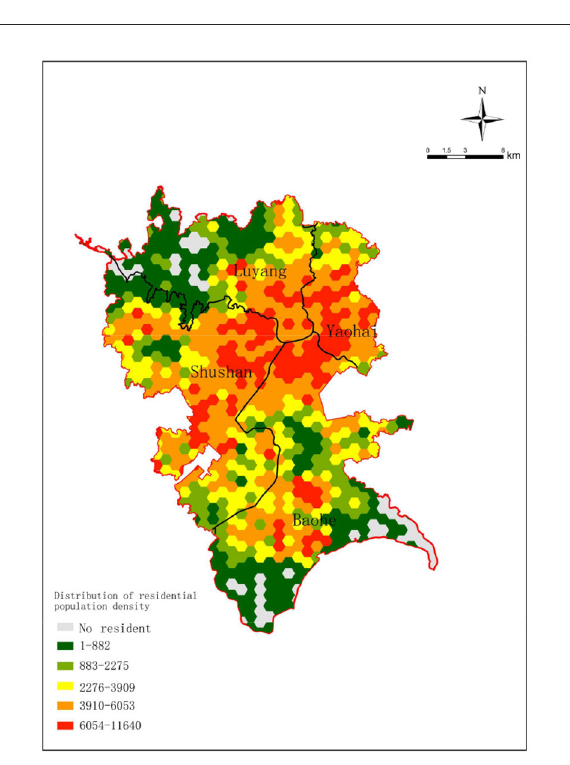
FIGURE3 Distribution of the residential population density in the central urban area of